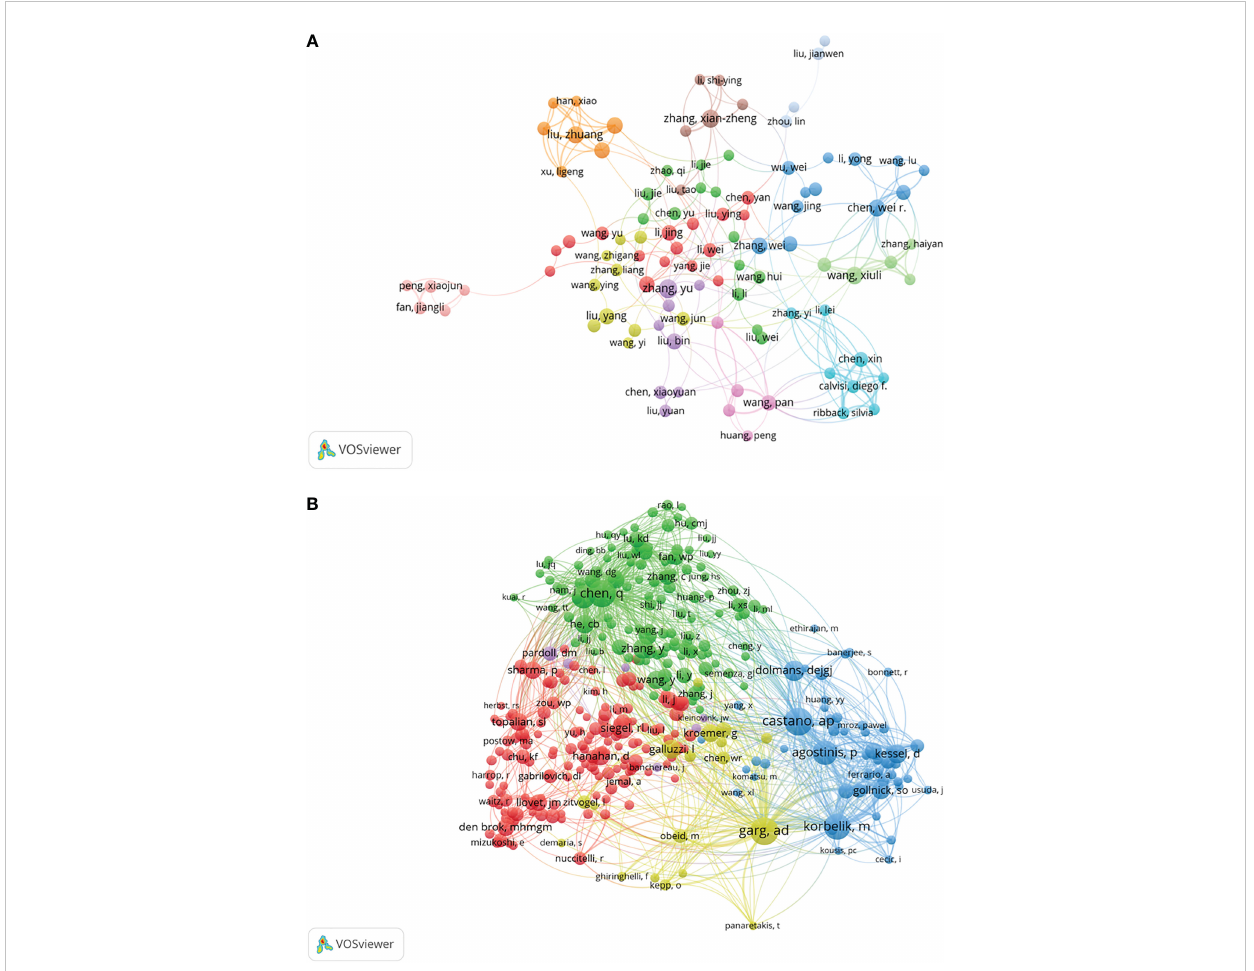
FIGURE 4 A network map showing authors (A) or co-cited authors (B) involved in tumor ablation and